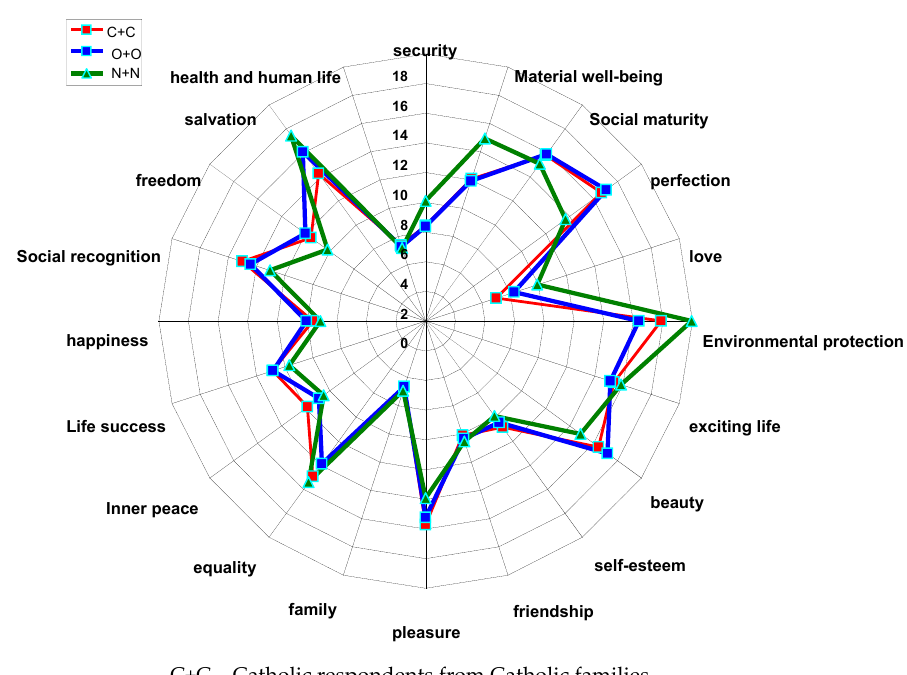
Figure 9. A list of terminal value preferences of Catholic and Orthodox respondents who do not declare any religion. Source: own study based on research results.